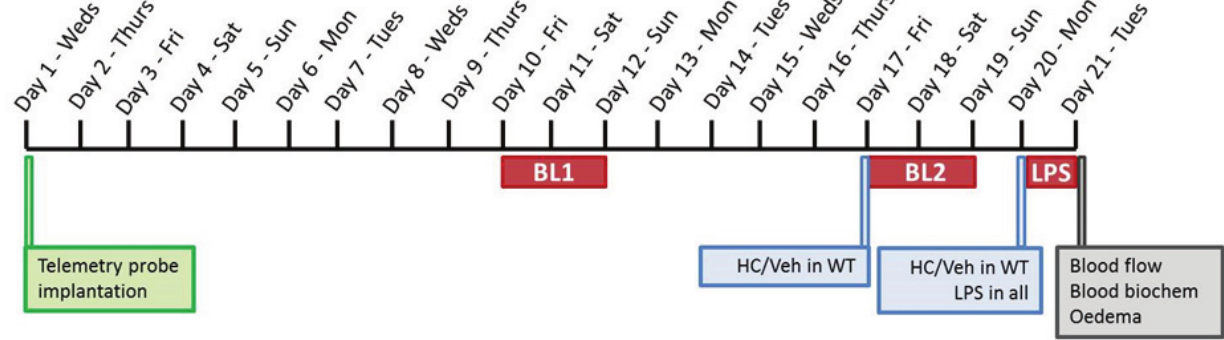
Figure 1. Timeline of experimental procedures. Mice were implanted with telemetry probes on day 1, and were left to recover for 10 days. Basal haemodynamic data were then recorded over a 48-h weekend period (BL1). The following weekend, WT mice were injected with either vehicle (10% DMSO in saline) or TRPV4 antagonist HC-067047 (10 mg/kg, i.p.) and a second 48-h baseline recording (BL2) was taken for all mice. TRPV4 KO mice were left untreated. Injections in WT mice were performed in a randomised and blinded fashion. Following the second weekend baseline recording, WT mice received a second injection of either HC-067047 or vehicle (consistent with initial treatment) and LPS (12.5 mg/kg, i.v.) was administered to all mice. Haemodynamic data were recorded over 24-h of endotoxaemia progression. Mice were then terminally anaesthetised for blood flow recording and ex vivo analysis. A separate cohort of naïve mice were included in blood flow and ex vivo